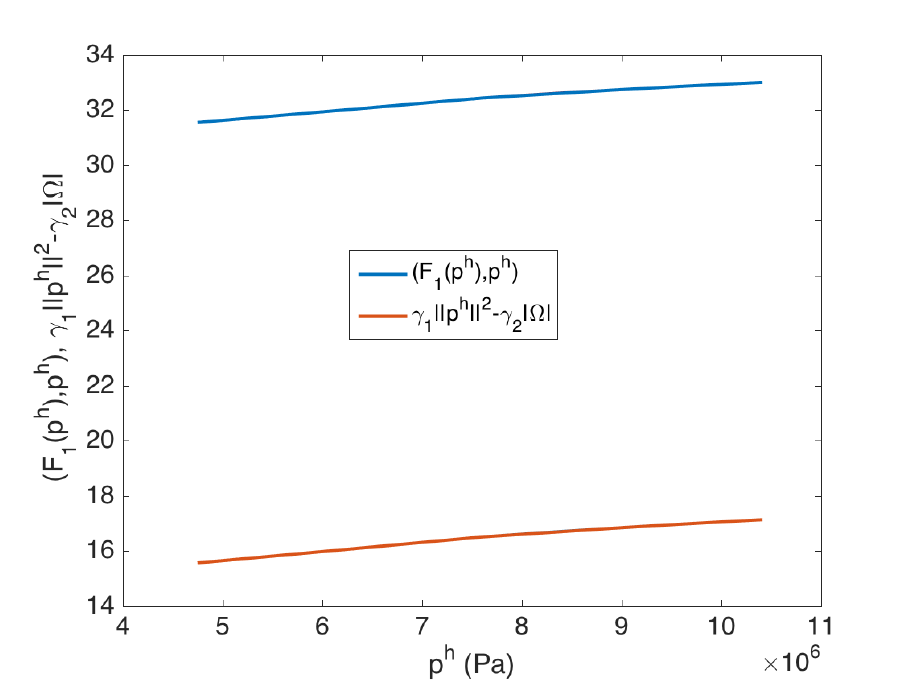
Figure 1. Numerical verification for the theoretical results in Lemma